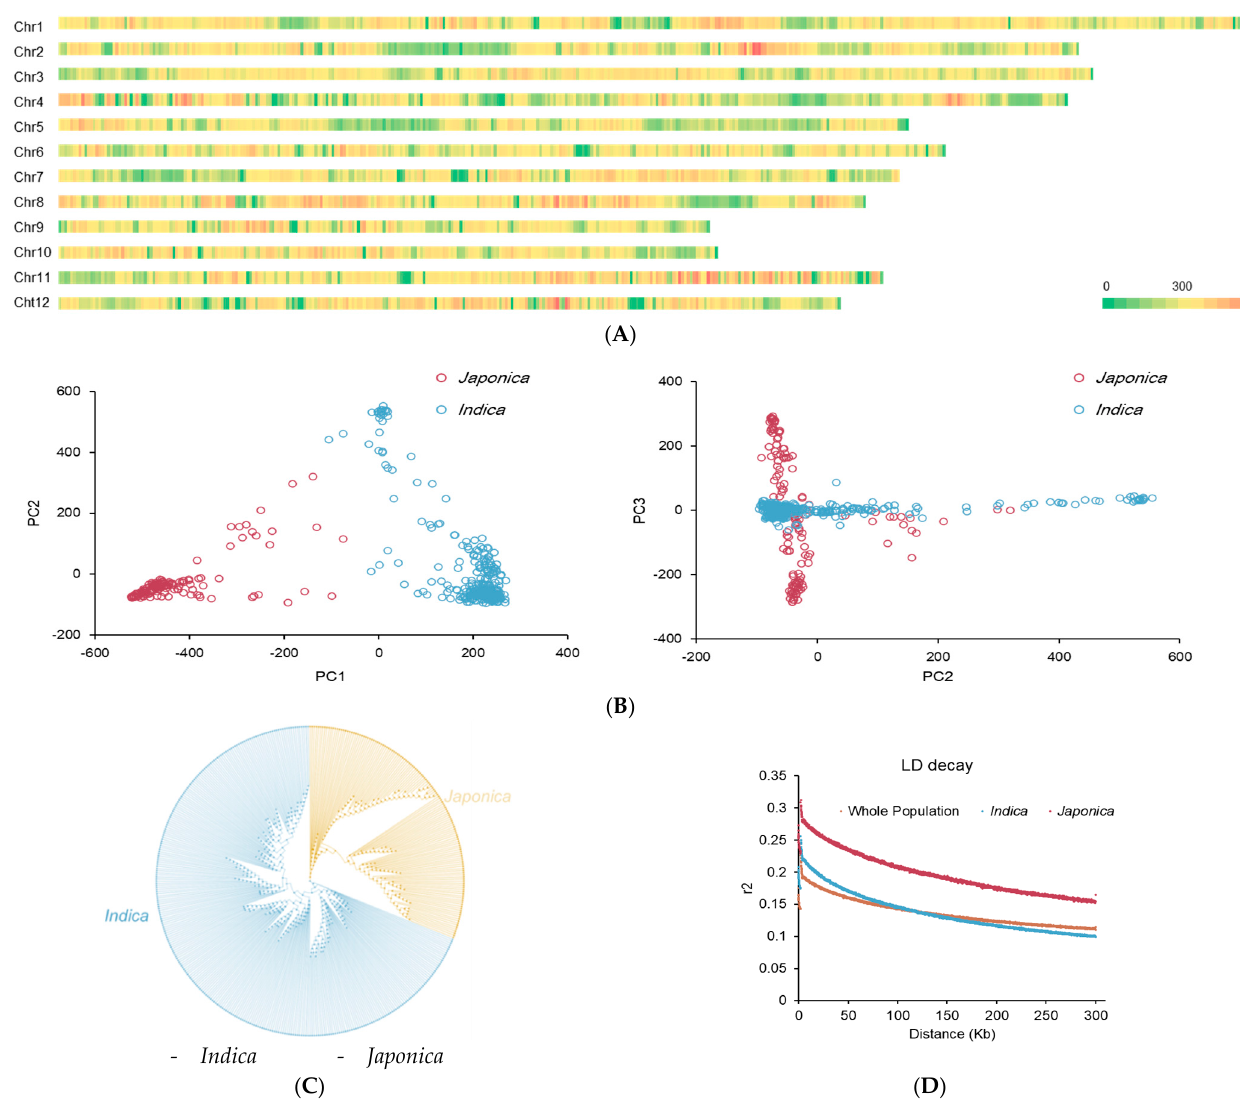
Figure 1. The distribution of SNPs, analysis of population structure, and LD decay of 456 rice accessions. ( A ) The distribution of SNPs in the rice genome analysis of population structure. ( B ) principal component, the red indicates the indica subspecies, while the purple indicates the japonica subspecies. ( C ) Phylogenetic tree: the blue indicates the indica subspecies, while the yellow indicates the japonica subspecies. ( D ) LD (linkage disequilibrium) decay of 456 rice accessions in the whole population, indica subspecies, and japonica subspecies, subspecies.